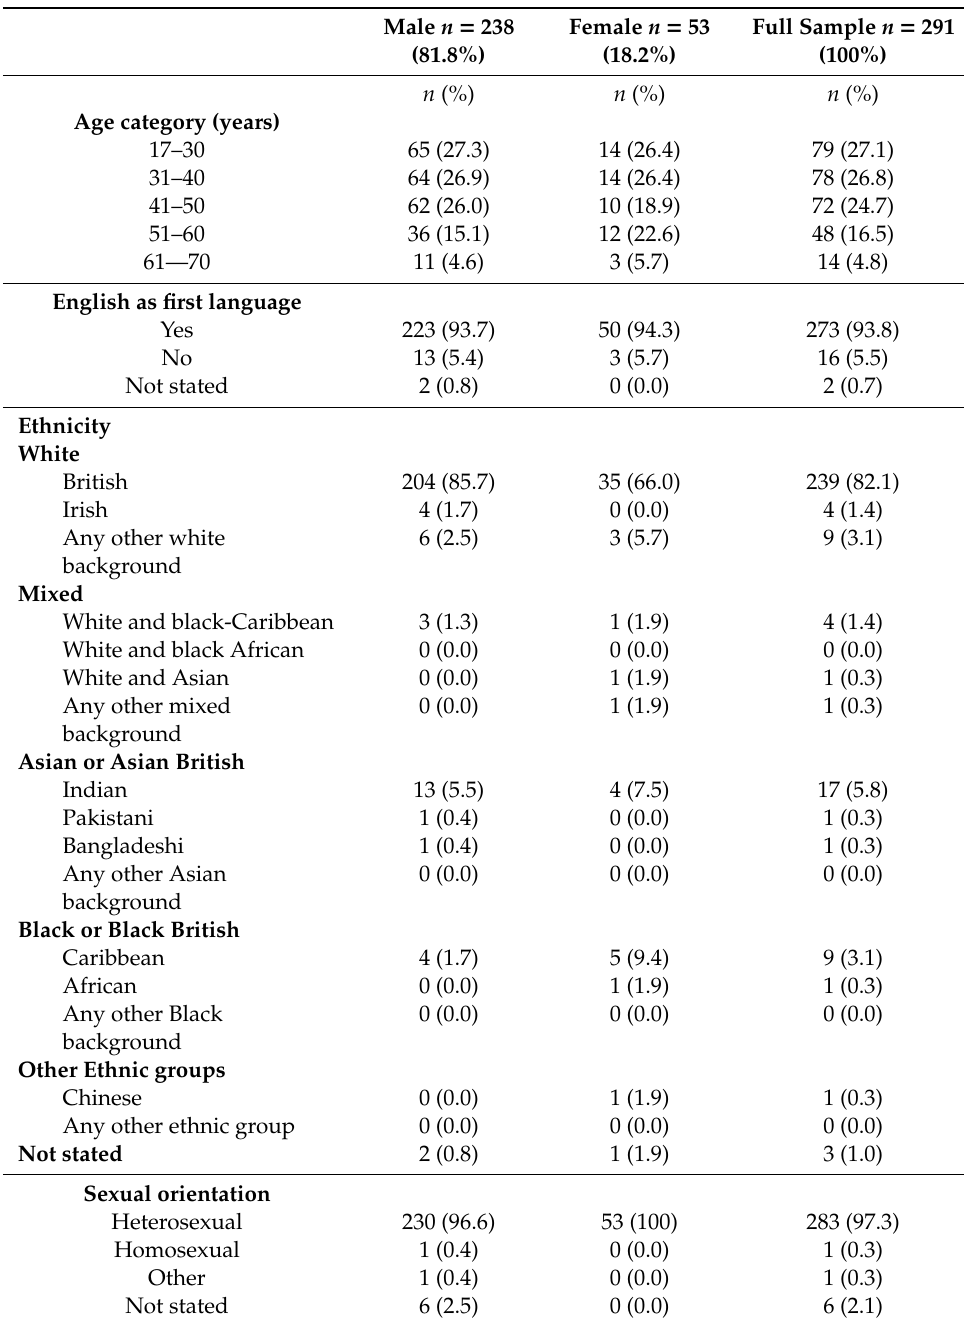
Table 2. Participant